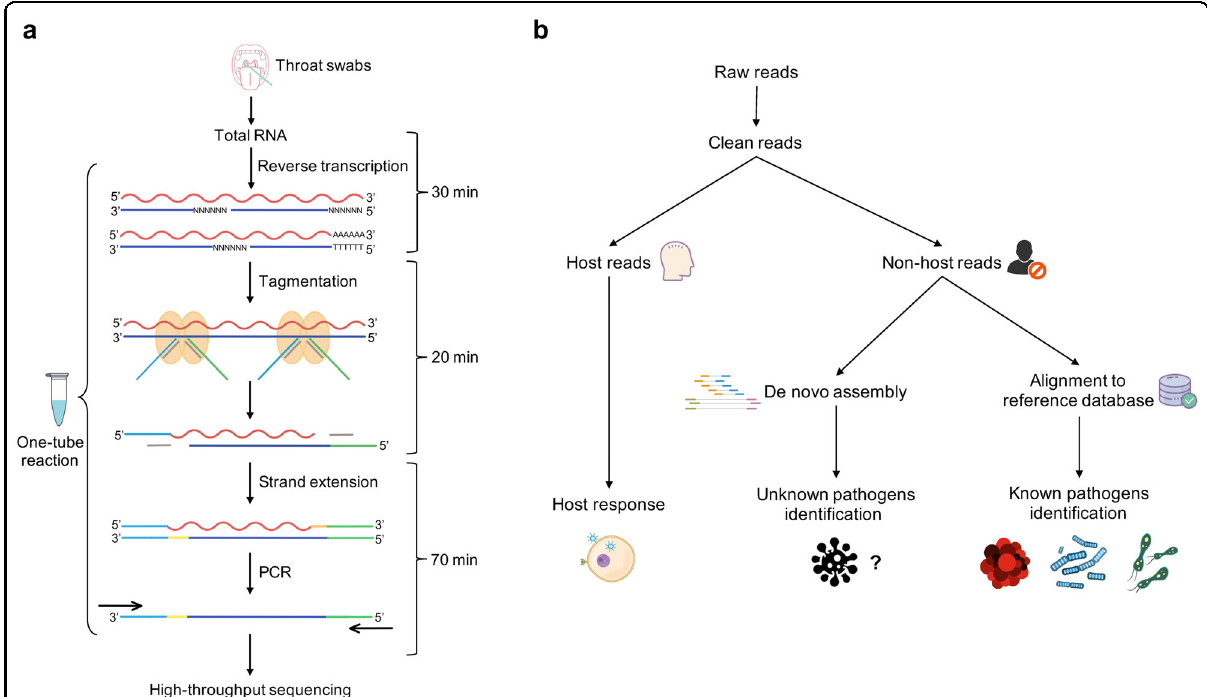
Fig. 1 Work fl ow of TRACE-seq enables metatranscriptomic sequencing for clinical diagnosis. a A wet lab protocol of TRACE-seq starting with total RNA extracted from throat swabs of COVID-19 patients. b A dry lab pipeline including known and unknown pathogen identi fi cation and host response